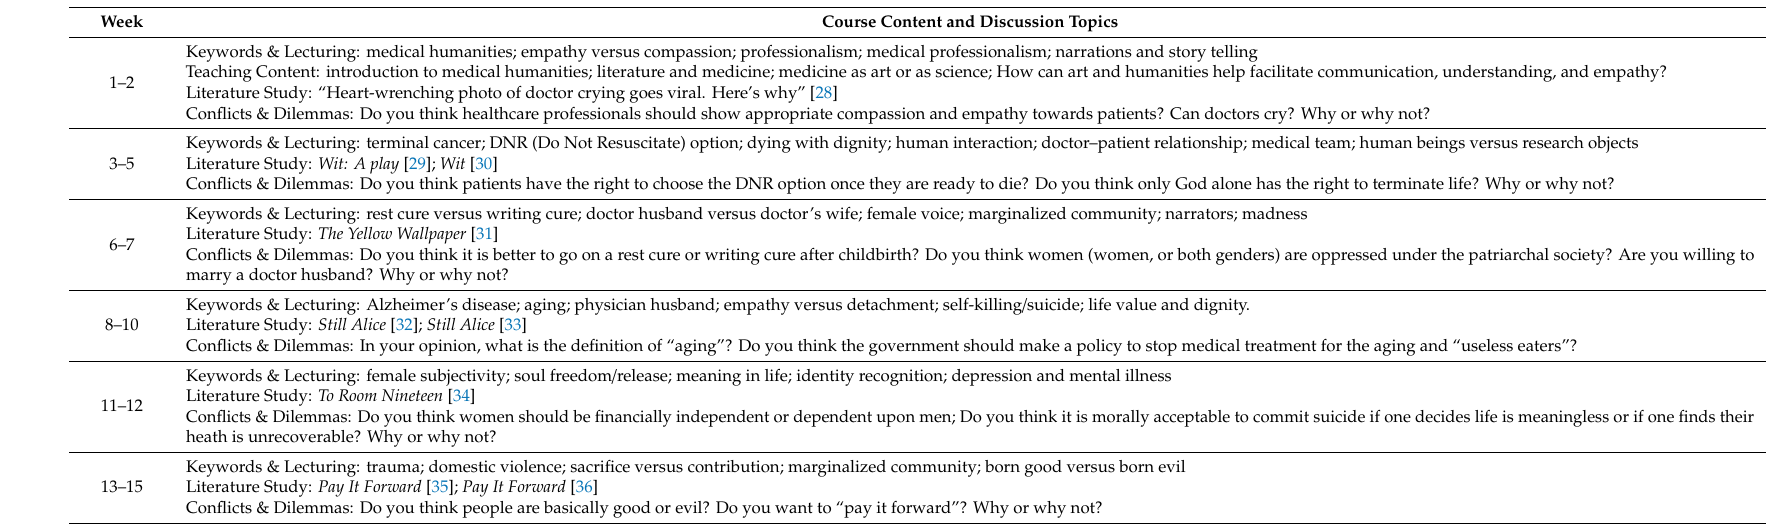
Table 2. Course content and discussion